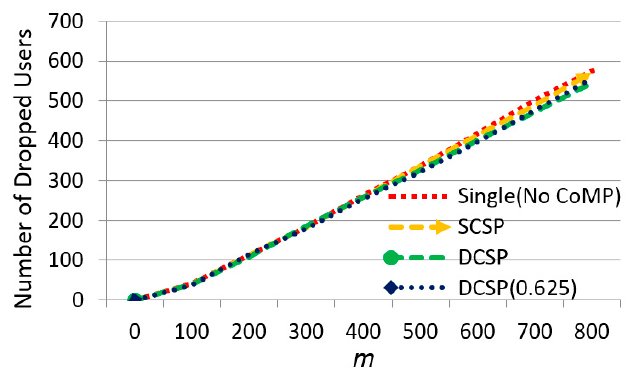
Figure 10. The effect of η on throughput (1-hop neighbors as candidates VS. 1-hope and 2-hop neighbors as